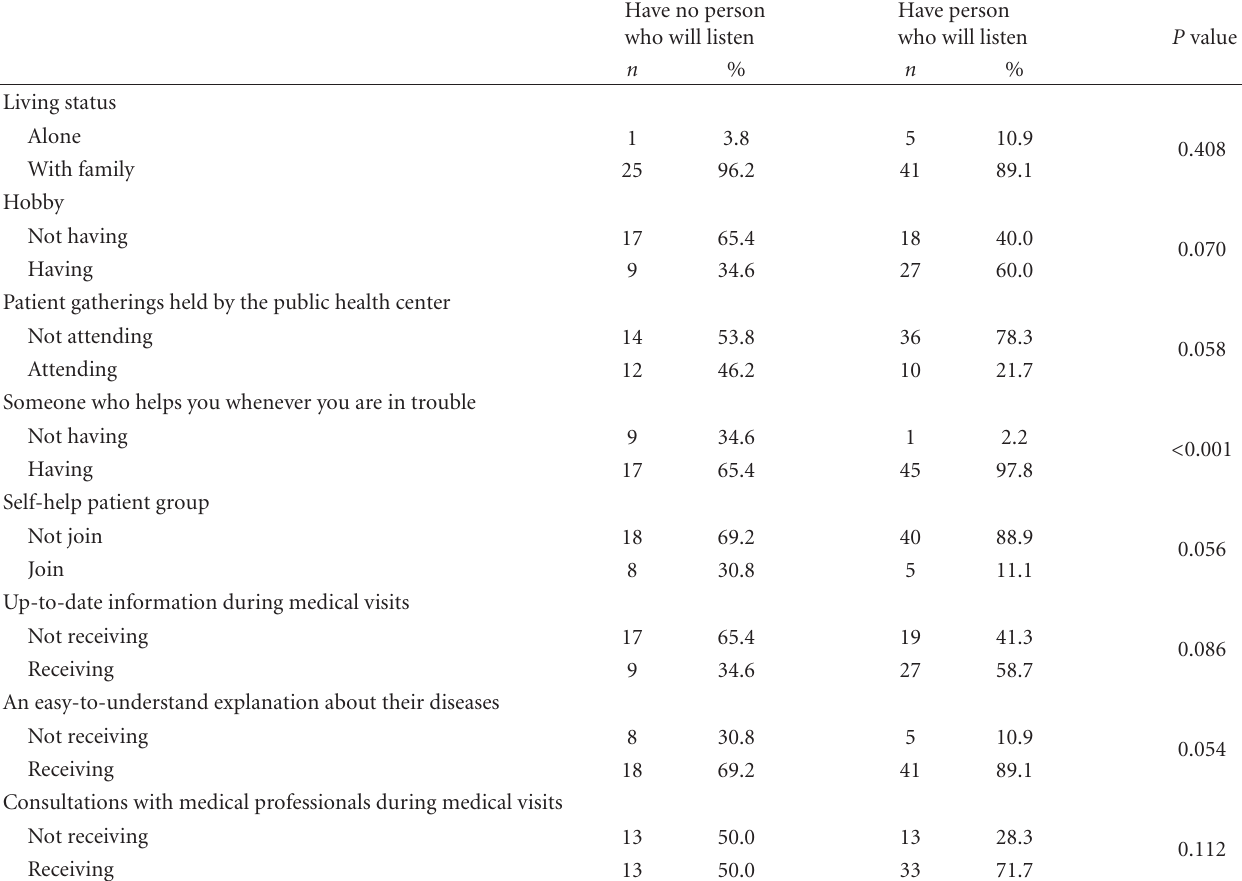
Table 5: Relation with a person who will listen empathically to anxieties or troubles with the use of welfare resources and medical